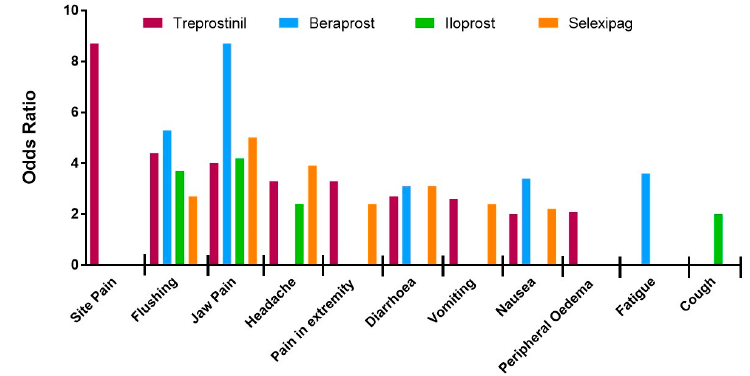
Figure 1. Likelihood of developing each adverse event during a trial period associated with prostacyclin mimetic (treprostinil, beraprost, iloprost and selexipag) treatment as determined by odds ratio.